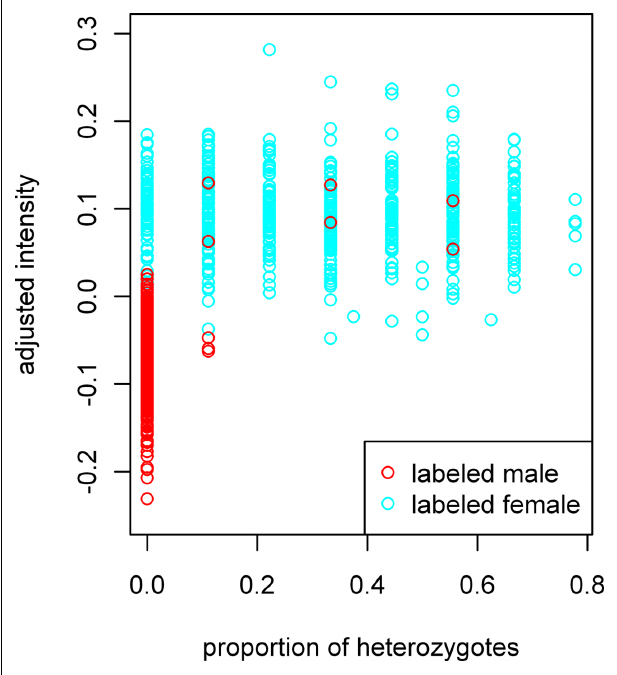
FIGURE 1 |Adjusted X-chromosome intensity versus proportion of heterozygous X-chromosome SNPs. Data forms into vertical bars because, with nine X-chromosome SNPs, a given sample may be heterozygous at zero, one, two, and theoretically up to nine SNPs.We see only eight main vertical bars because no samples with genotypes for all nine SNPs were heterozygous for eight or more SNPs. Intermediate heterozygosities result from samples with genotypes for fewer than nine SNPs. X-chromosome intensity values on the vertical axis have been adjusted for the sample mean GenCall score and sample mean intensity across autosomal SNPs, as described in the